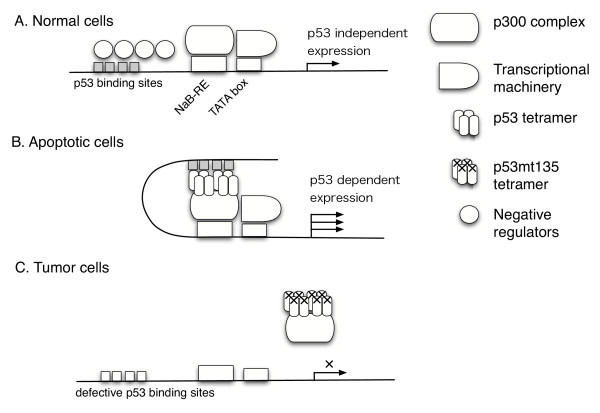
Working model of p53 action to IGFBP-3 promoter. In normal cells, IGFBP-3 is induced by such as growth hormone and IGFs, and steady level of expression is observed in some cells. As the deletion of p53 binding sites enhances the expression of IGFBP-3, the binding of negative regulators is expected (Fig. 6A). In apoptotic cells, p53 tetramers at high level of expression bind to upstream binding sites. These tetramers recruit the p300 complex to its binding site, and a p53 dependent high level of expression is observed (Fig. 6B). In tumor cells, deletions, mutations, methylations of p53 binding sites, or mutations of p53 such as p53mt135, disturb the binding of p53 tetramers to its binding sites, and this prevents the binding of p300. As a result, the expression of IGFBP-3 is suppressed in tumor cells.